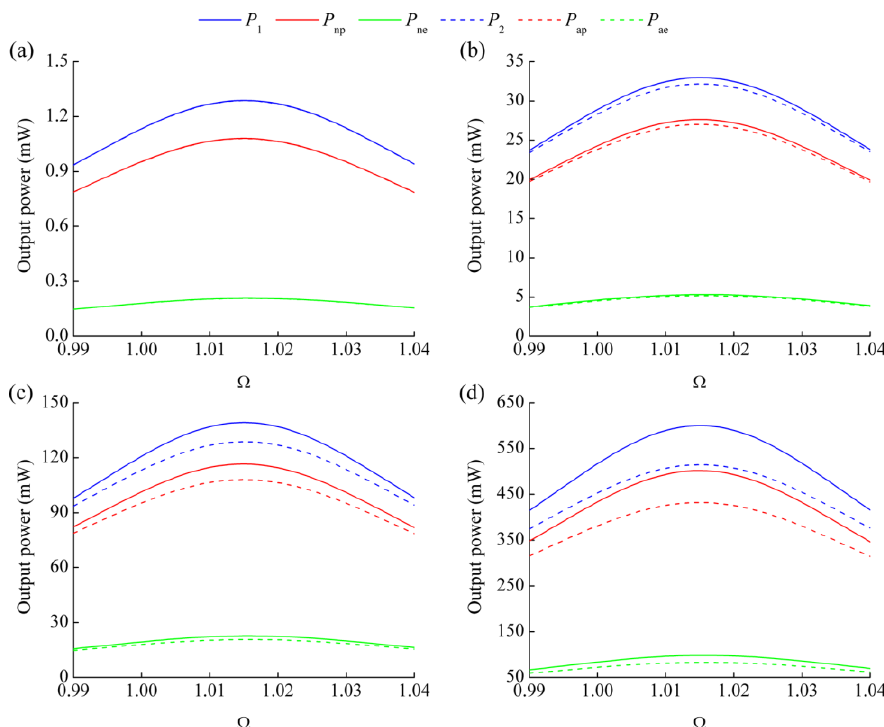
Figure 3. Output power versus excitation frequency ratio for different excitation accelerations: ( a ) 2 m/s 2 ; ( b ) 10 m/s 2 ; ( c ) 20 m/s 2 ; ( d ) 40 m/s 2 . Table 2. Comparison of peak power from numerical and analytical solutions.